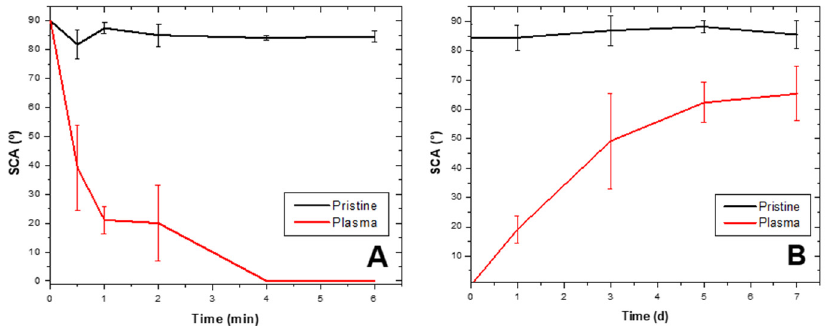
Figure 2. LDPE static contact angle changes after plasma treatment and recovery. ( A ) LDPE sheet static contact angle (SCA) decrease after 6-min treatment with O 2 plasma discharge (ablation curve). ( B ) Hydrophobic recovery in LDPE sheets after being submitted to O 2 plasma discharge and stored for 7 days, represented as changes in SCA.